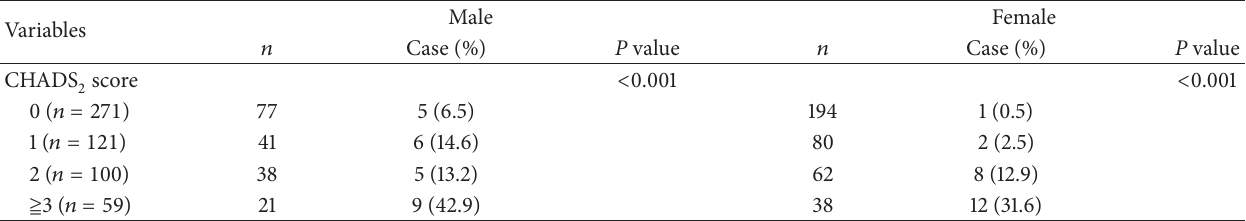
Table 2: MACEs among Cushing’s syndrome patients with different CHADS